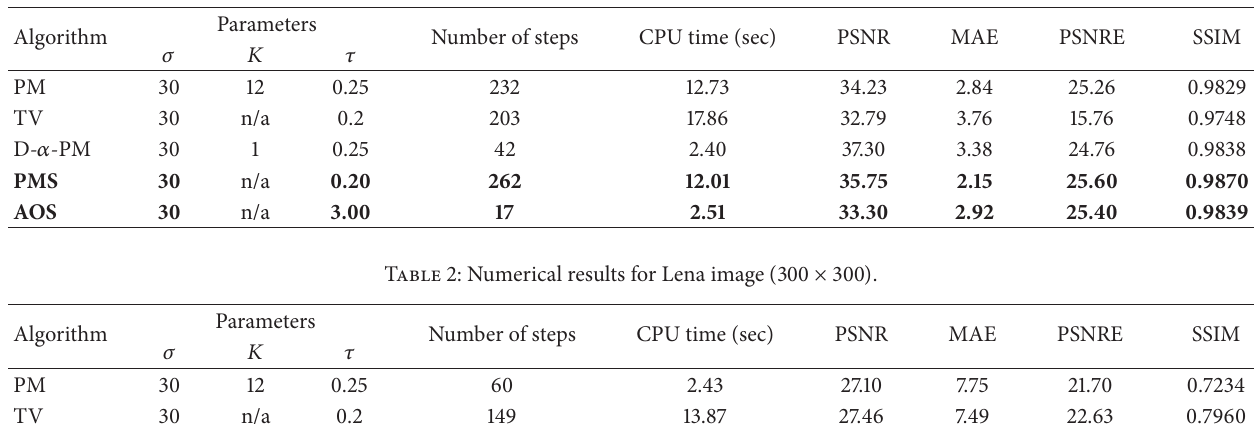
Table 1: Numerical results for synthetic image (300 × 300) .